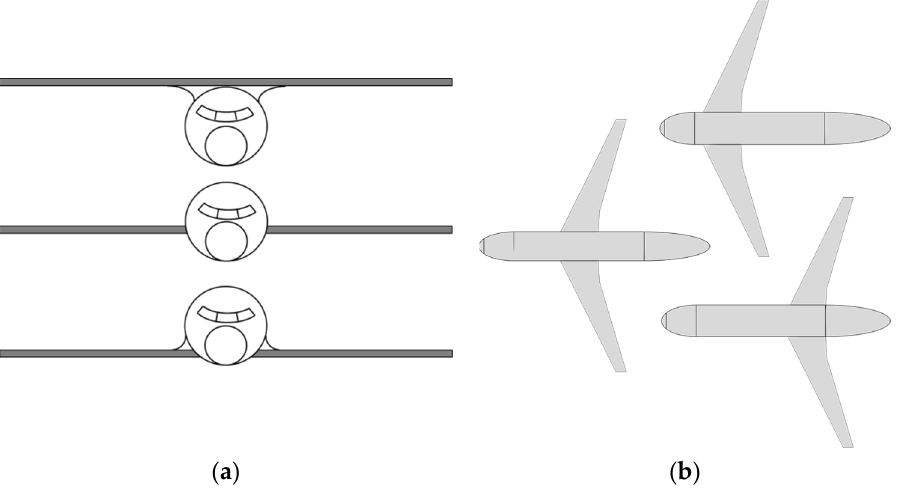
Figure 6. Fuselage arrangements with similar aerodynamic performance. ( a ) Front view. ( b ) Top